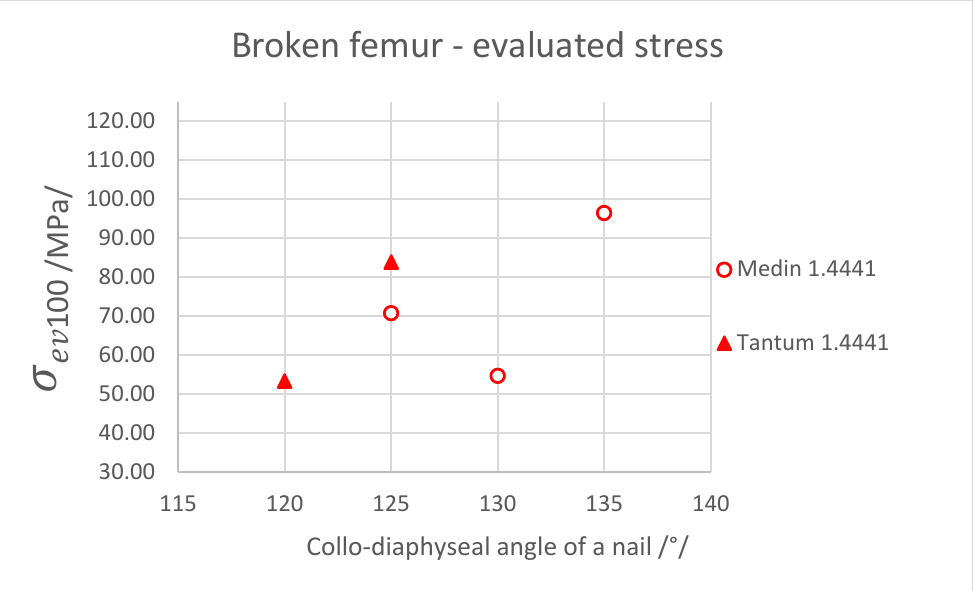
Figure 19. Dependence of evaluated HMH stress (MPa) on nail collo ‐ diaphyseal angle (broken femur).